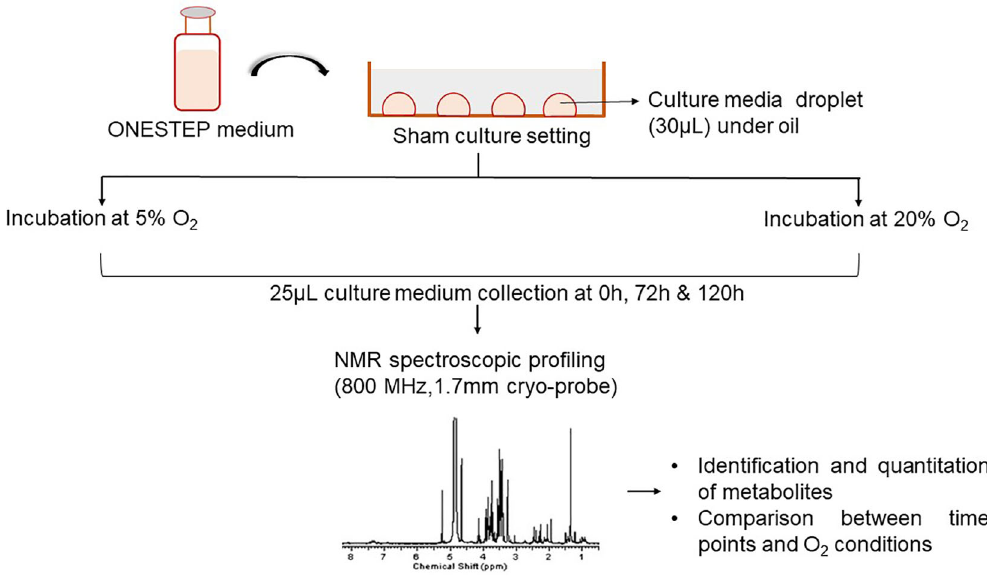
Figure 1. Overview of the experimental design. NMR=nuclear magnetic